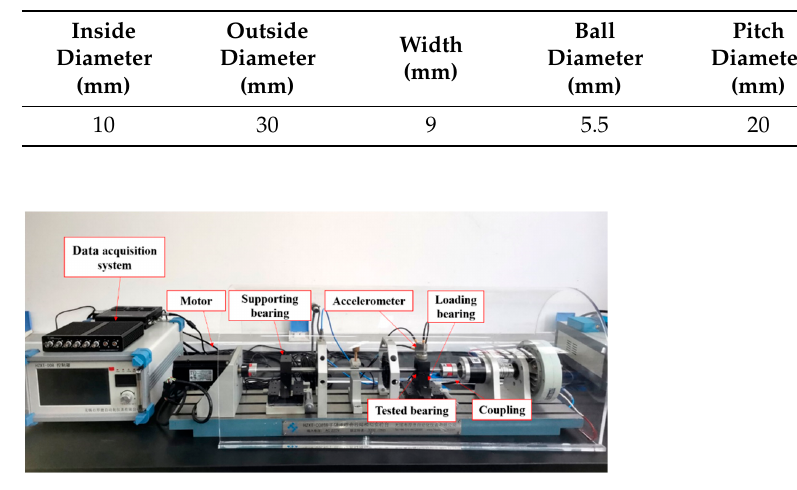
Figure 10. Bearing rotor fault test bench. (1) 6200-NR NSK Bearing with Weak Inner Ring Fault